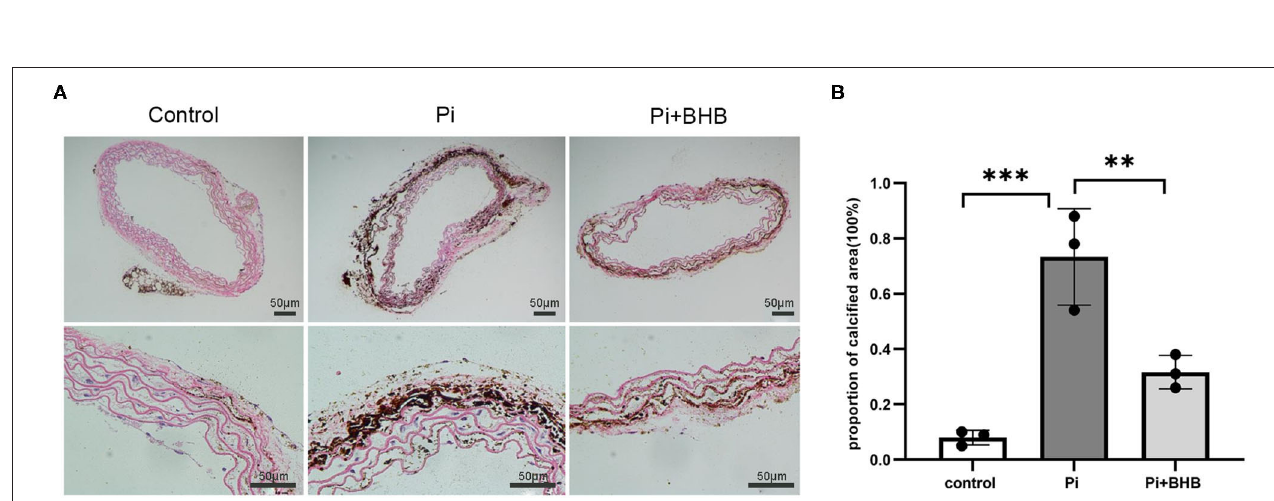
FIGURE 1 | BHB partly mediated the relations between MAs and TAC severities. BHB, β -hydroxybutyric acid; MAs, metabolic abnormalities; TAC, thoracic aorta calcification.